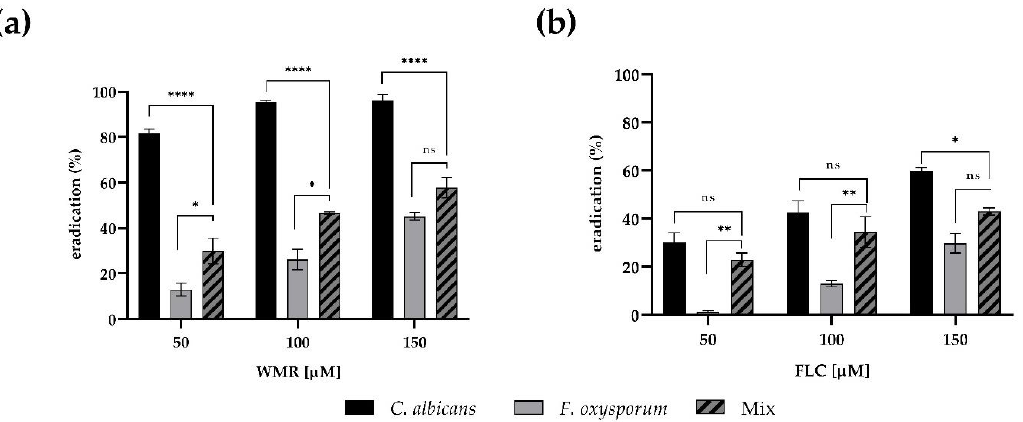
Figure 4. Eradication of WMR (panel a ) and FLC (panel b ) on mono- and dual-species biofilms formed on microplate surfaces quantified using the CV method. Statistical significance: * p < 0.05; ** p < 0.01; **** p < 0.0001; ns = not significant (Tukey’s test). The eradication of mixed biofilms of 50% was only observed at the highest WMR